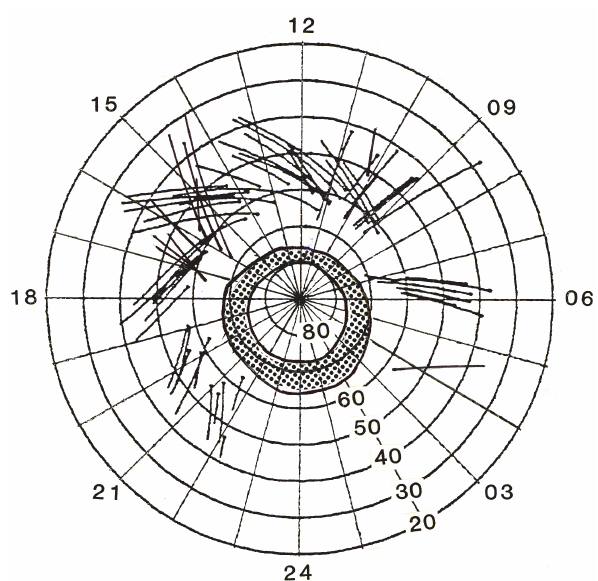
Fig. 4. Latitudinal and local-time distribution of LHR band emis- sions. The polar plot is coordinated with an invariant latitude and magnetic local time. The absence of LHR band emissions around midnight is due to our suspending satellite observations during that time. The hatched area shows the average auroral oval (Feldstein, 1963).